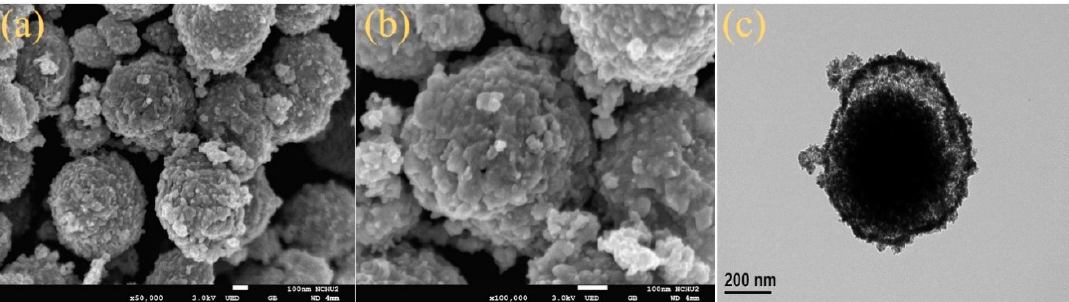
Figure 1. ( a , b ) SEM and ( c ) TEM images of Zn-Co-S BHS.